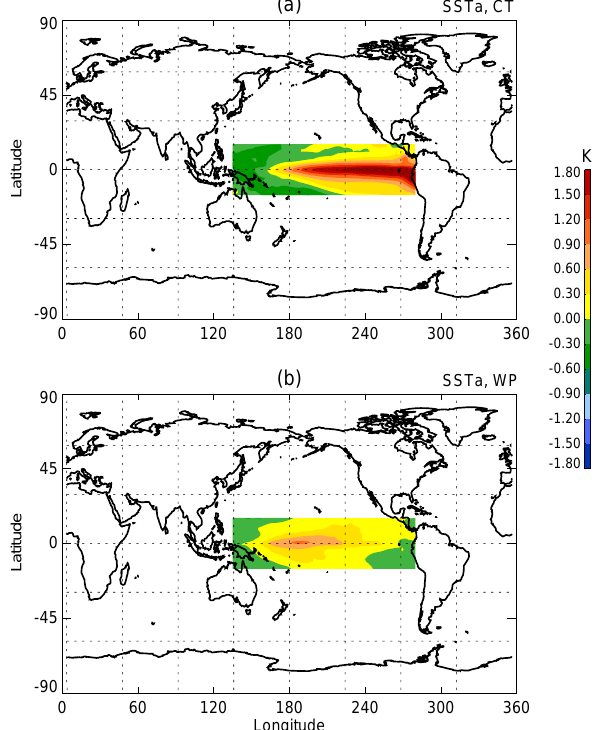
Fig. 1. SSTAs in the tropical Pacific Ocean referred to as canonical El Ni˜no events (a) and El Ni˜no Modoki events (b) . The logogram Figure 1. SSTAs in the tropical Pacific Ocean referred to as canonical El Niño events CT on the top right corner of a panel represents the canonical El Ni˜no events. The logogram of WP represents the El Ni˜no Modoki events. CT and WP in the following figures have the same (a) and El Niño Modoki events (b). The logogram CT on the top right corner of a panel represents the canonical El Niño events. The logogram of WP represents the El Niño Modoki events. CT and WP in the following figures have the same meaning. 5